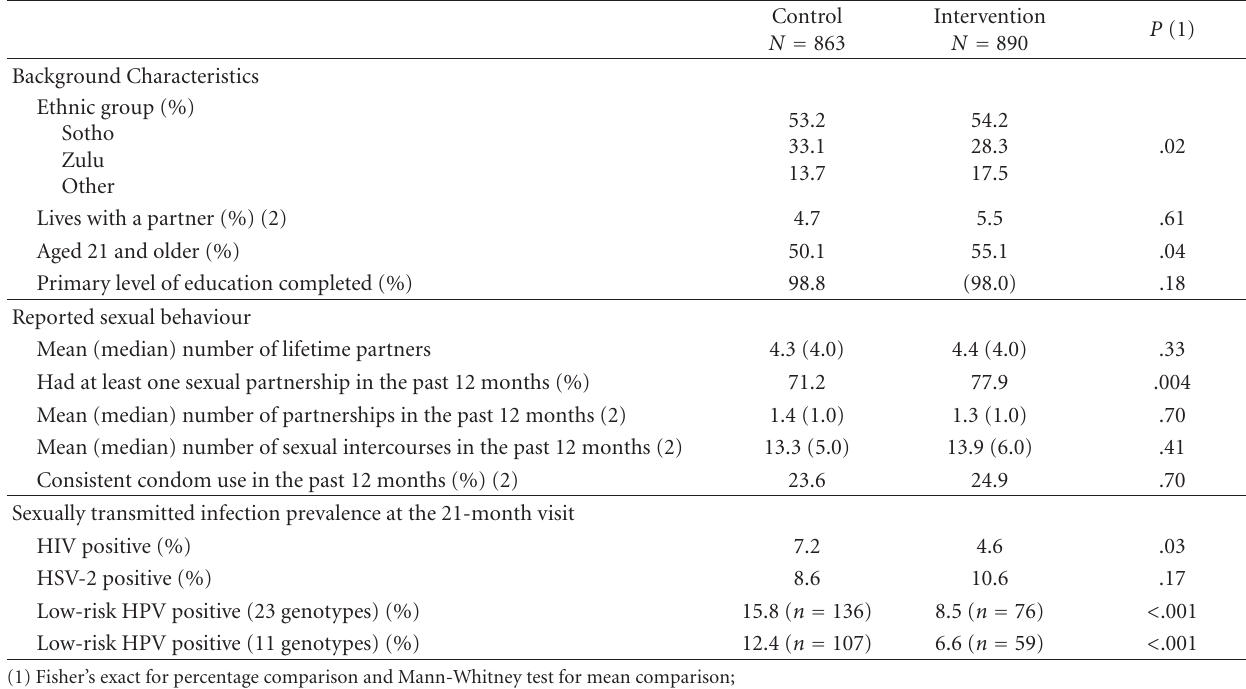
Table 1: Background characteristics, reported sexual behaviour, and HIV, HSV-2 and low-risk HPV prevalence of the study